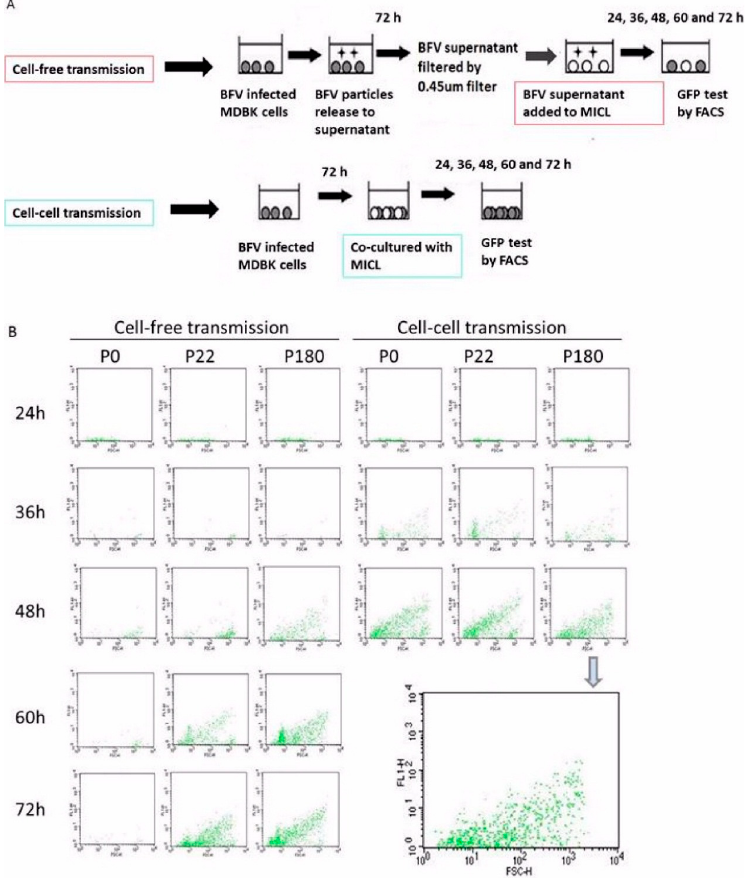
Figure 9. Cell–cell transmission is retained in HT-BFV. The ability of HT-BFV to spread by cell–cell transmission was examined using the original BFV-Riems and HT-BFV from different passages in MDBK cells. ( A ) Experimental approach comparing BFV transmission by cell-free virus or by spread via co-cultivation (modified according from [33]). Original BFV–Riems and BFV from middle (p. 22) and late passages (p180) were cultured in MDBK cells in 10 cm dishes. When more than 80% of the cells were infected, cells were cultivated with MICL cells at a ratio of 1:6. The corresponding supernatants were filtered using a 0.45 µ m filter and applied to target cells for cell-free transmission. Infection was measured at different time points (24 h, 36 h, 48 h, 60 h, and 72 h) by detecting BFV Tas-activated Gfp expression using flow cytometry. Cell-free transmission is indicated by a red box. Cell-cell transmission is indicated by a blue box. ( B ) Representative result of BFV infection via cell–cell and cell-free transmission. BFV-infected MICL cells were harvested at different time points. Cells were washed thrice in PBS and filtered before flow cytometry using a BD FACSCalibur flow cytometer. The enlarged panel at the right side represents data from cell-free transmission of passage P180 at 48 h